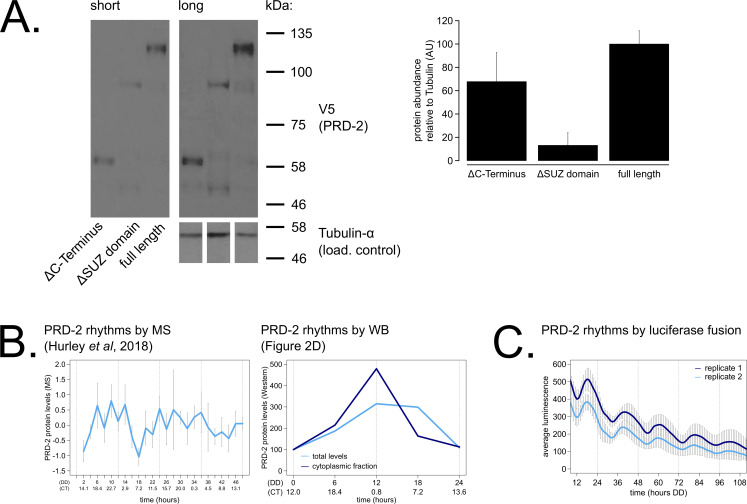
PRD-2 protein levels are slightly rhythmic and are detectable in protein domain deletion mutants.PRD-2 protein levels were measured from at least three biological replicates using strains where the endogenous NCU01019 locus was replaced with V5-tagged domain deletion constructs: prd-2ΔC-Terminus(Δ440–790), prd-2ΔSUZ(Δ345–431), and full length. Long and short exposures of a representative immunoblot are shown with quantification relative to tubulin loading controls (A). The C-terminal deletion strain has ~68% PRD-2 levels compared to the full length control, and the SUZ deletion has ~13% levels. Both are above the low levels of qa-driven NCU01019 needed to induce the long period phenotype (Figure 1E). MS data from a previous study (Hurley et al., 2018) revealed low amplitude rhythms in PRD-2 abundance with a broad peak in the subjective circadian night and early morning (~CT18 – 2). Circadian Time (CT) was calculated as described previously (Kelliher et al., 2020). PRD-2 abundance was also quantified from the localization time course (Figure 2D) relative to tubulin and relative to the first time point. Peak PRD-2 protein abundance was observed in the subjective morning from both MS and immunoblot data (B), corresponding with the rise in frq transcript levels (Aronson et al., 1994). To confirm rhythms in PRD-2 protein expression, the complete NCU01019 5’-UTR and coding sequence, including 951 bp of upstream promoter sequence but lacking its endogenous 3’-UTR sequence, was fused in-frame with codon-optimized luciferase (Gooch et al., 2008). This construct was transformed into the prd-2WT background at the csr-1 locus, and PRD-2 protein cycles in abundance (τ = 21.7 ± 0.8 hr). PRD-2 protein peaks during the circadian day (CT7.5±1) by luciferase fusion (C), slightly delayed relative to its morning peak by western blot and MS.